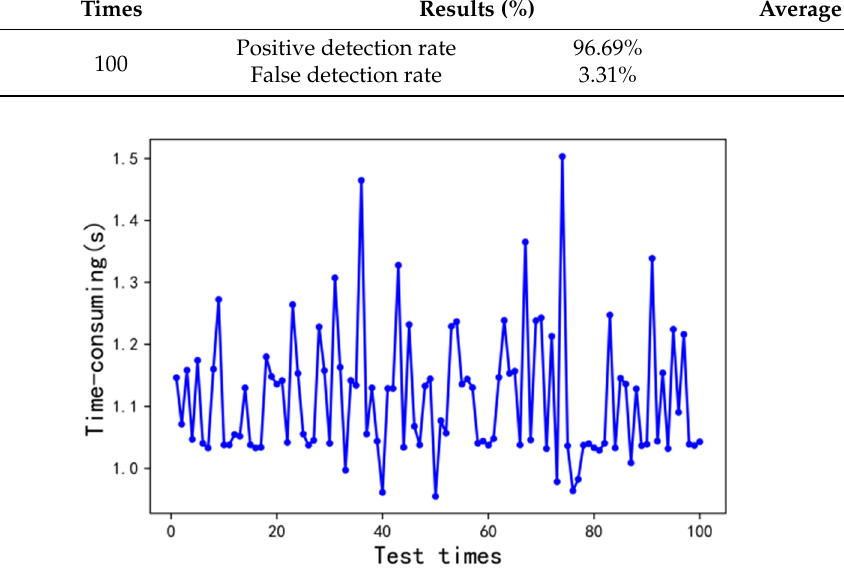
Figure 10. Actual scene, 100 iterations.